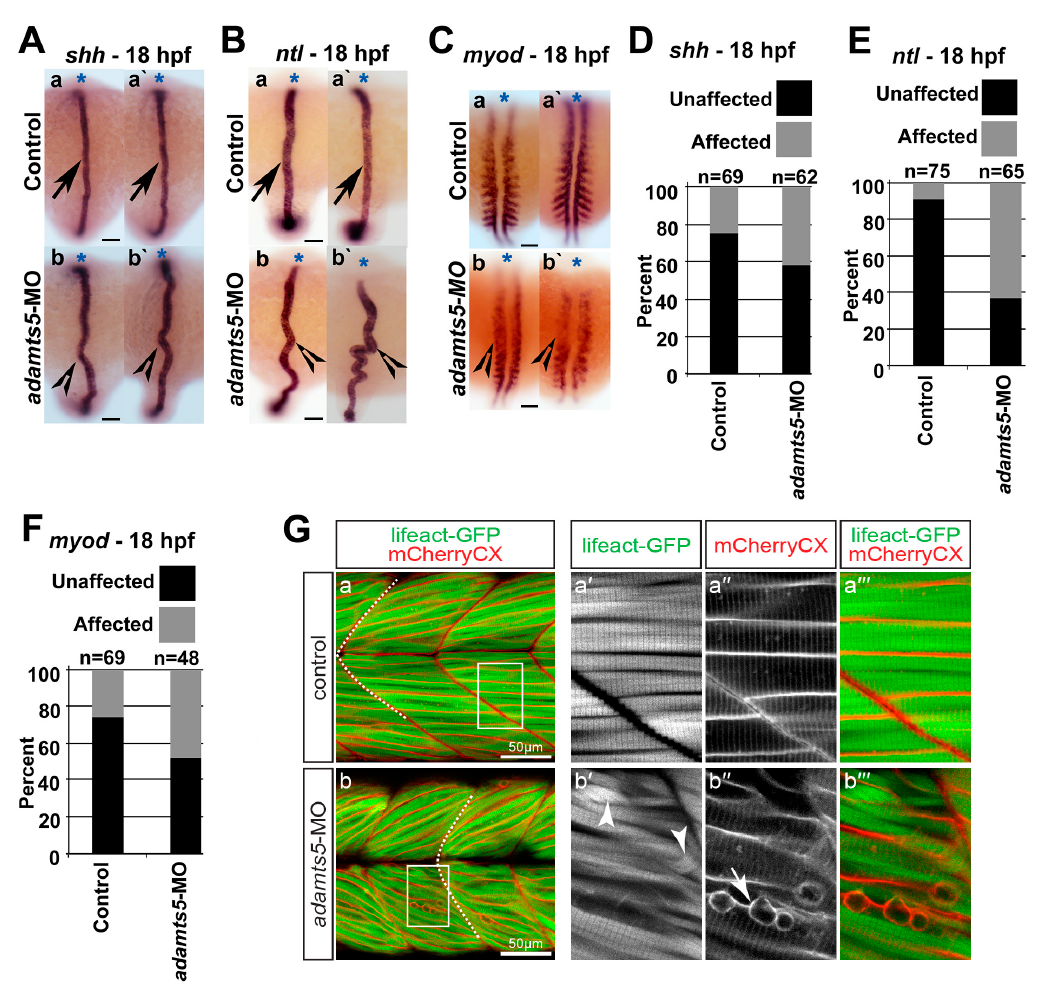
Figure 2. Notochord morphogenesis and muscle fiber formation is perturbed in adamts5 morphant embryos. ( A ) Expression of shh in the notochord of 18 hpf control ( a , a ′ , arrows) and adamts5 morphant ( b , b ′ , open arrowheads) embryos, with medio-lateral deviation in the adamts5 morphants ( b , b ′ ), with anterior indicated (*); ( B ) Expression of ntl in the notochord of 18 hpf control ( a , a ′ , arrows) and adamts5 morphant ( b , b ′ , open arrowheads) embryos, with medio-lateral deviation in the adamts5 morphants with anterior indicated (*); ( C ) Expression of myod in adaxial and paraxial mesoderm of 18 hpf control embryos ( a,a ′ ) and its perturbation in adamts5 morphants ( b , b ′ , open arrowheads) with anterior indicated (*); ( D ) Quantitation of affected notochords in control and adamts5 morphant embryos demarcated by shh in Figure 2A; ( E ) Quantitation of affected notochords in control and adamts5 morphant embryos demarcated by ntl in Figure 2B; ( F ) Quantitation of embryos with perturbed myod expression in control and adamts5 morphant embryos demarcated in Figure 2C; ( G ) Double-transgenic Tg(acta1:lifeact-GFP) / Tg(acta1:mCherryCaaX) embryos, in which thin filaments are marked green and sarcolemma red, reveal loss of muscle integrity in 3 dpf adamts5 morphants. Muscle fibers of control injected larvae feature the typical striation of the myofibril and regular myofibers within chevron-shape somites, indicated by a dashed line ( a ). The boxed area in a is magnified in a ′ – a ′′′ . Myofibril striation is partially lost within adamts5 morphants (arrowhead in b ′ ) and the sarcolemma of the myofibers disrupted (arrow in b ′′ ). The boxed area in b is magnified in b ′ – b ′′′ . Scale bar = 50 μ m.